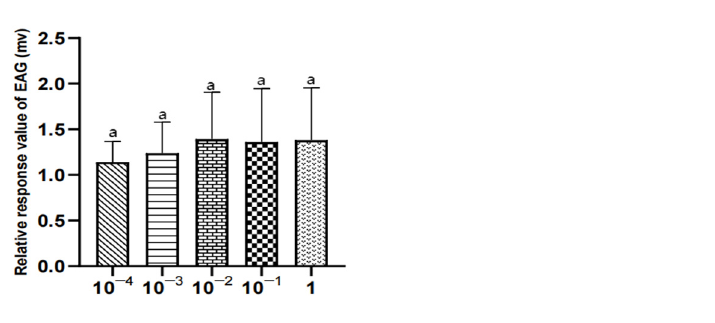
Figure 19. EAG responses of male W. magnifica to different concentrations of 1-octen-3-ol.